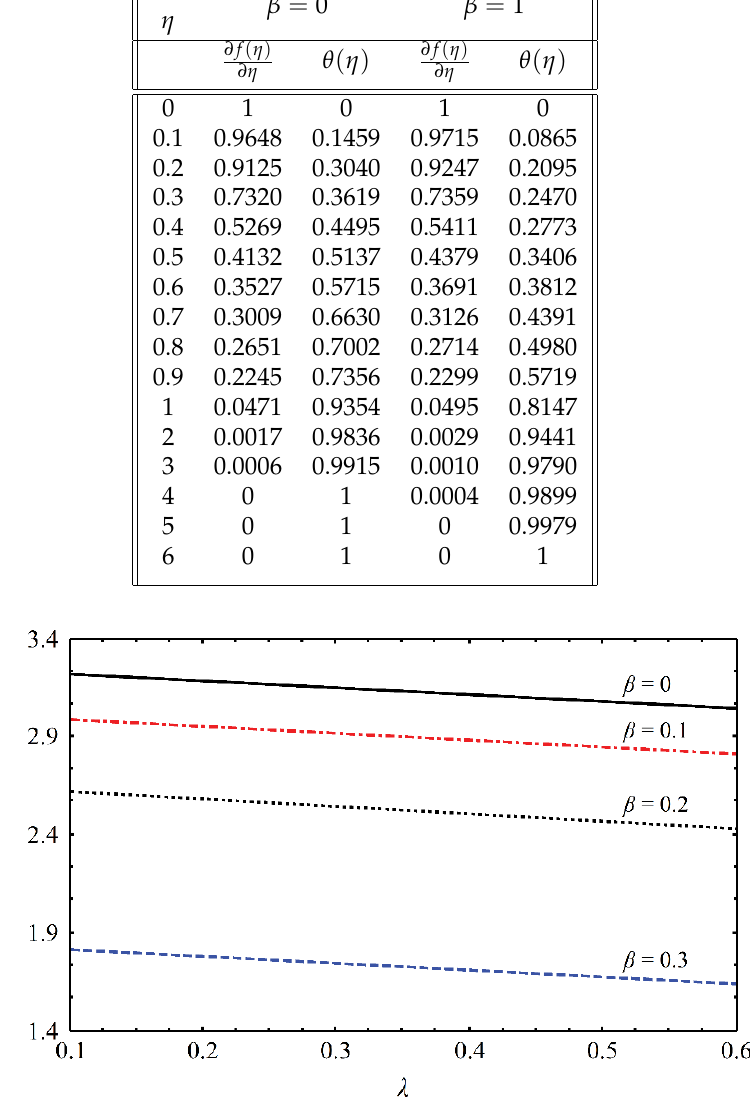
Table 6. Velocity and temperature distributions with parameters presented in Table 1.